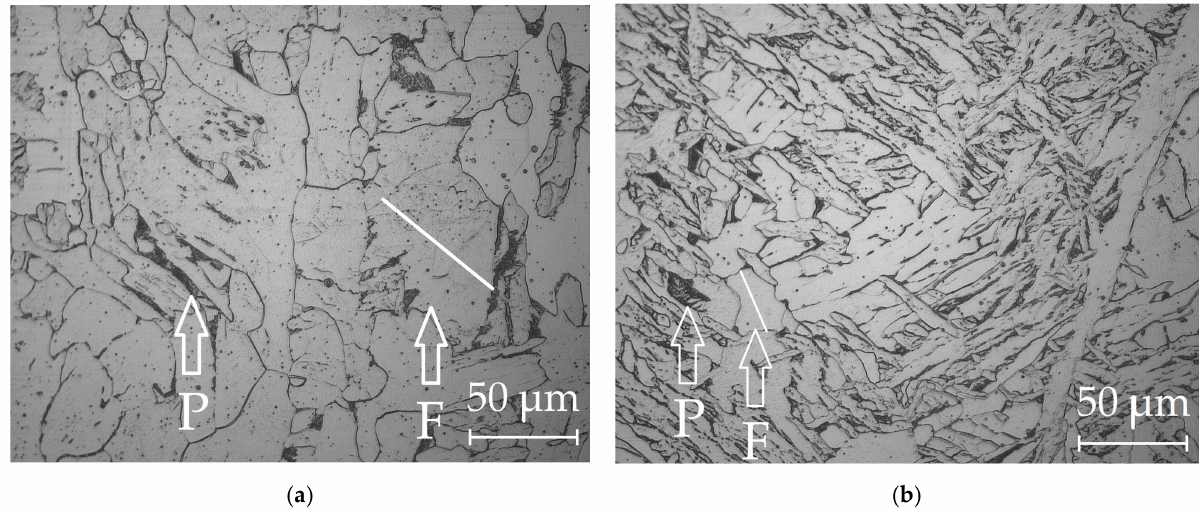
Figure 15. The typical microstructure of the in the weld metal center: ( a ) standard G3Si1 wire; ( b ) G3Si1 wire with Ni-LaF 3 coating. The arrows indicate the grains of ferrite (F) and pearlite